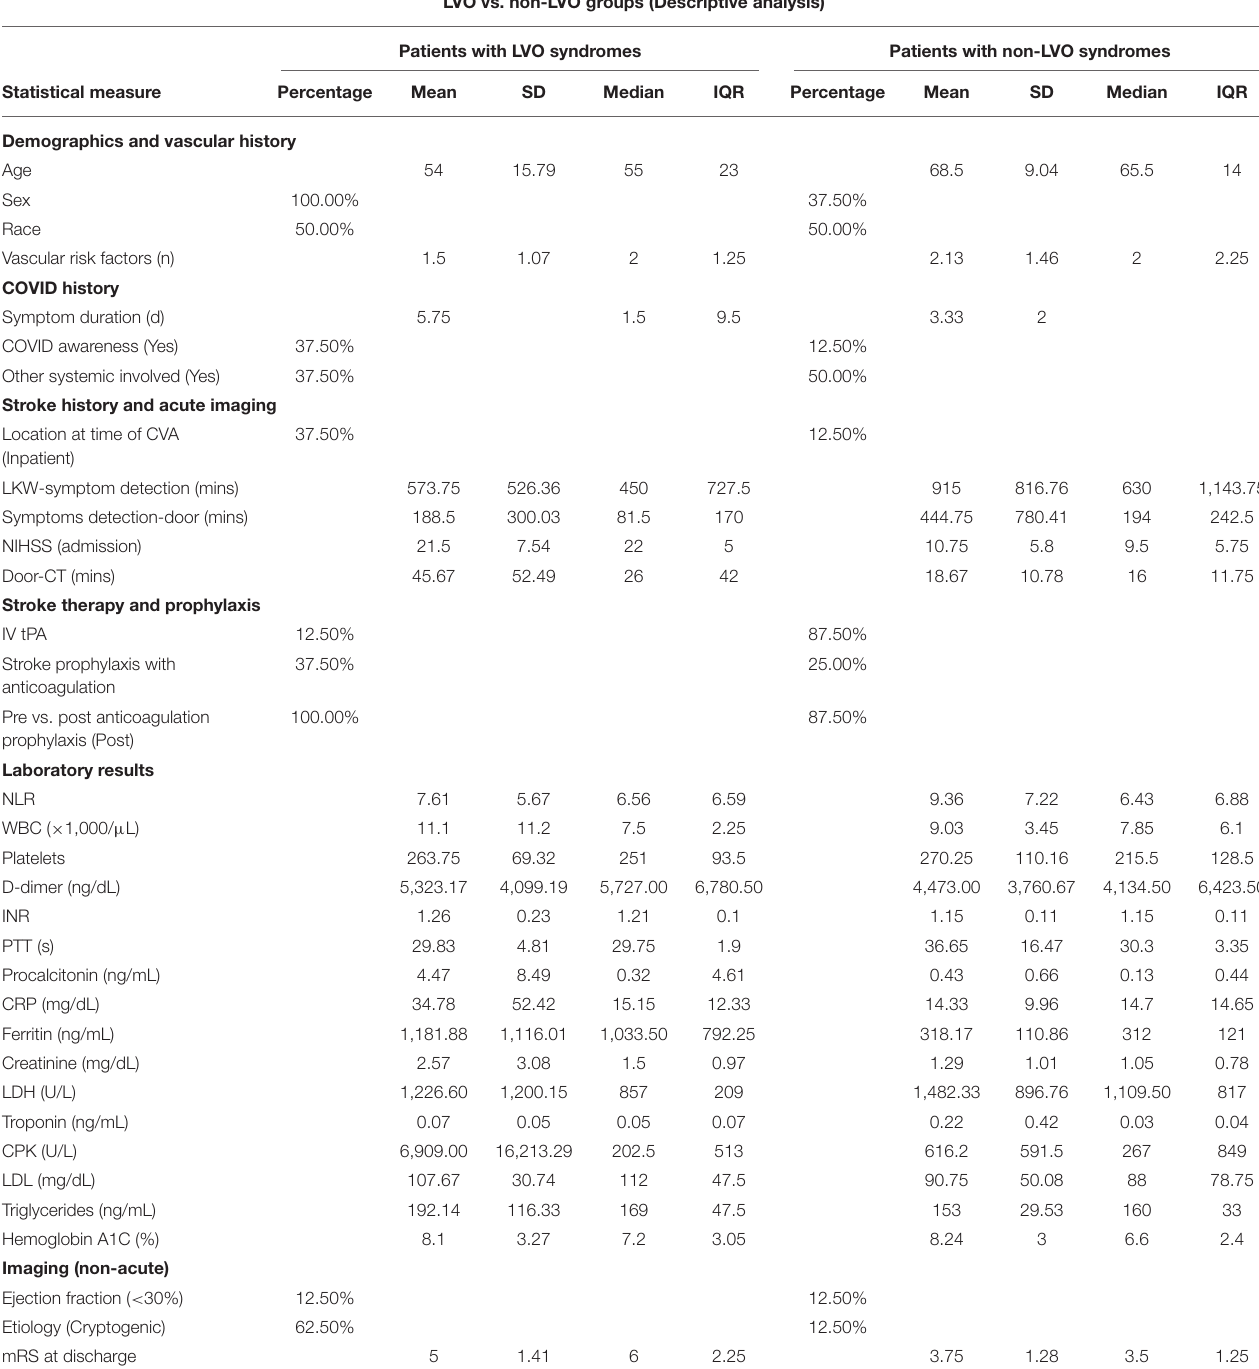
TABLE 3 | Comparison between LVO vs. non-LVO (Descriptive).